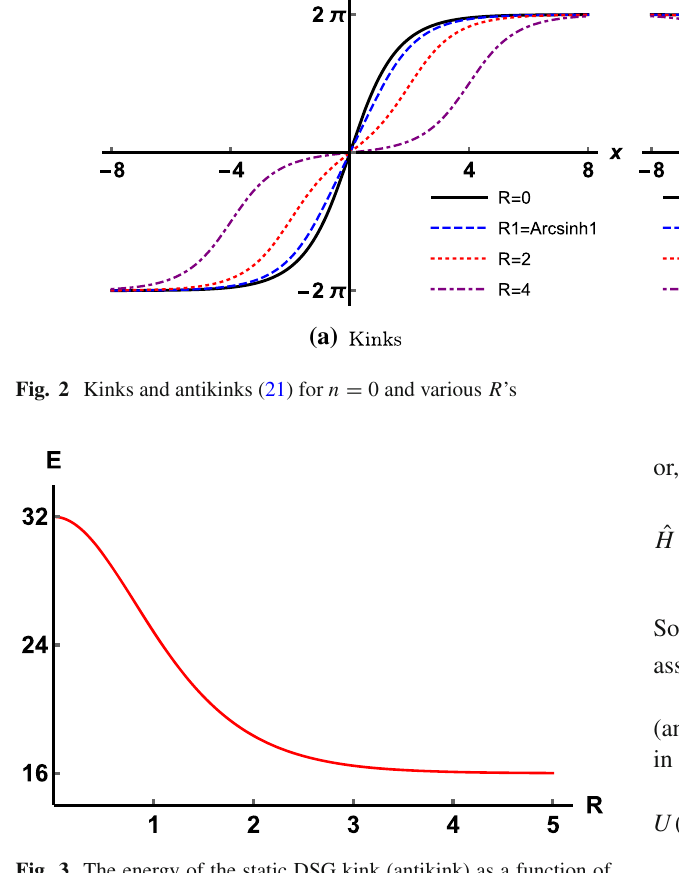
Fig. 3 The energy of the static DSG kink (antikink) as a function of the parameter